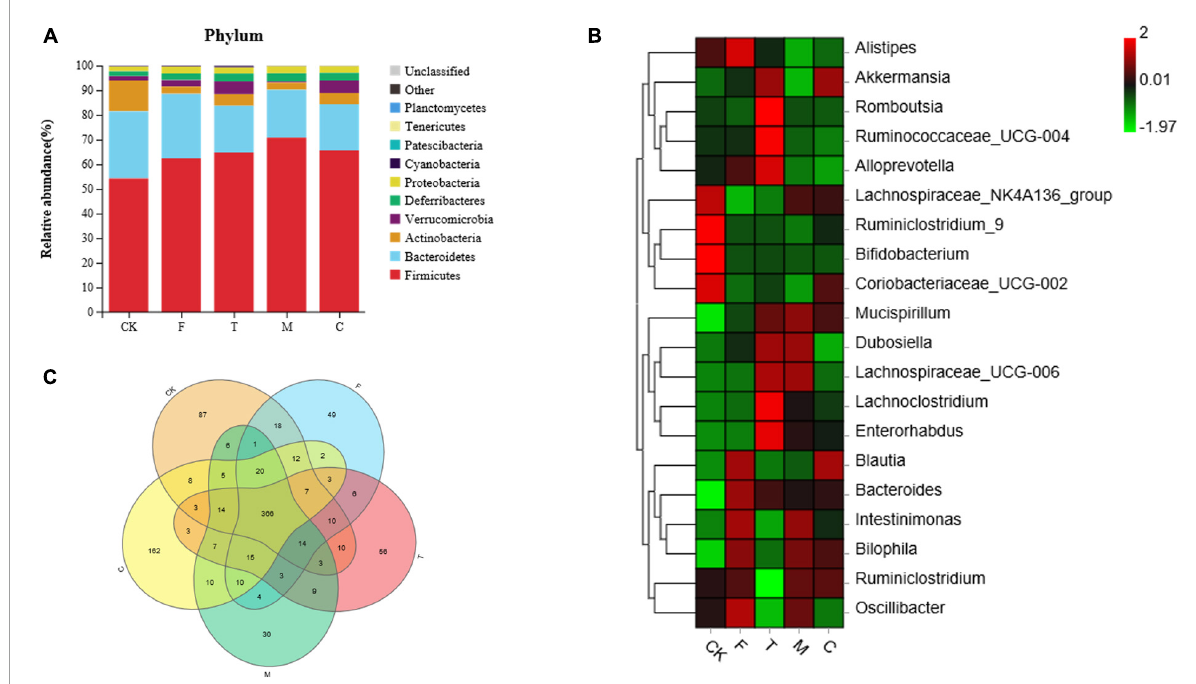
FIGURE5 Green tea powder with different qualities modulated the gut microbiota in high-fat diet induced obesity mice. (A) Cecal microbiota composition at the phylum level. (B) Heatmap of the cecal microbiota at the genus level. (C) Venn diagram of intersection relation in the operational taxonomic units (OTUs) of cecal microbiota among